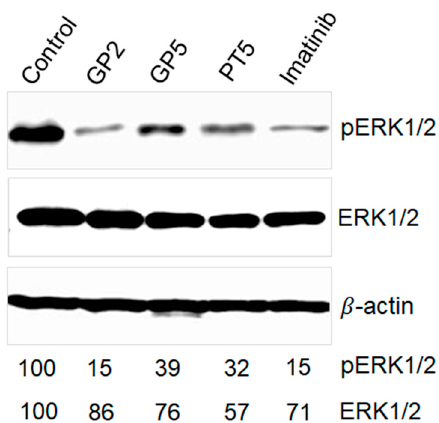
Figure 3. Superimposition of PT5 (magenta) and 1c (green) into ATP binding site of ABL kinase (PDB: 1IEP) as predicted by MOE 2019.0101 followed by a zoom-in separate view for each compound. Amino acids are depicted in blue sticks. All heteroatoms are colored by element. Ligand-protein interactions are shown as black-dash lines. Some amino acid residues are hidden for clarity purpose.